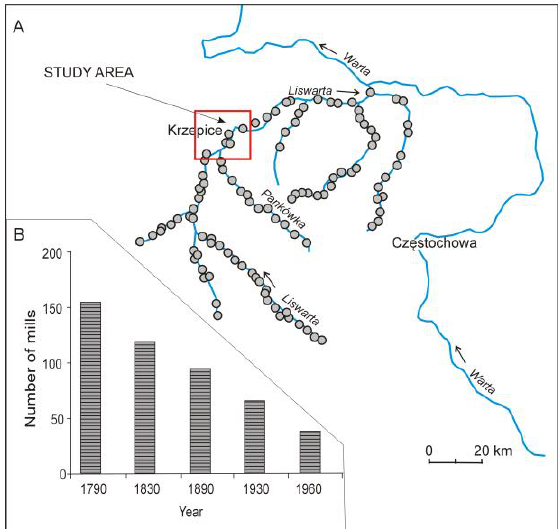
Fig. 3. Locations of watermills in the River Liswarta catchment (A) and changes in their numbers from 1790 to 1960 (B) (based on Fajer, 2011,